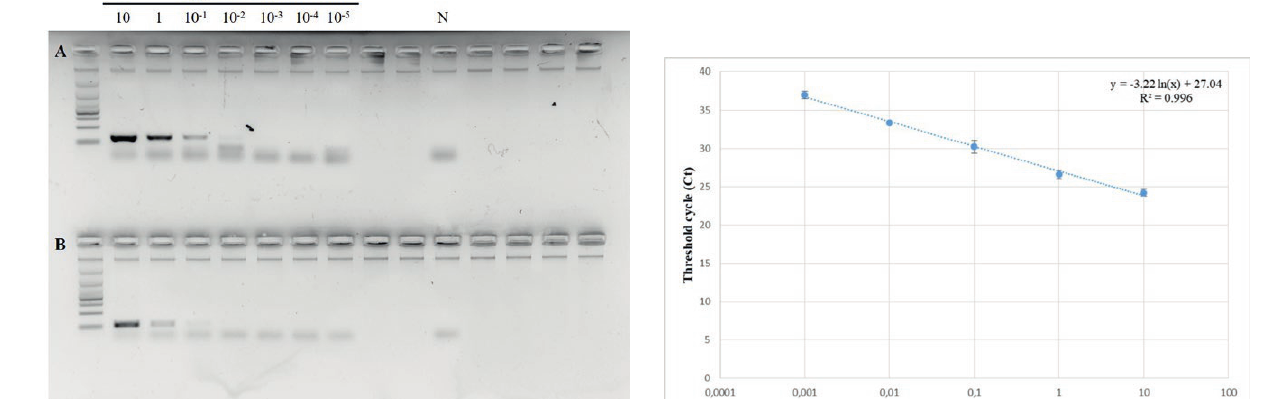
Figure 3. Single dissociation peaks of melting curves at 81.84 ± 0.22°C, which confirmed the specificity of the primer set TubOc_68fw TubOc_197rev. The peaks were obtained from the amplification of the dilutions (from 10 ng µL -1 to 100 fg µL -1 ) in water of the Colletotrichum ocimi genomic DNA of strain CVG190.